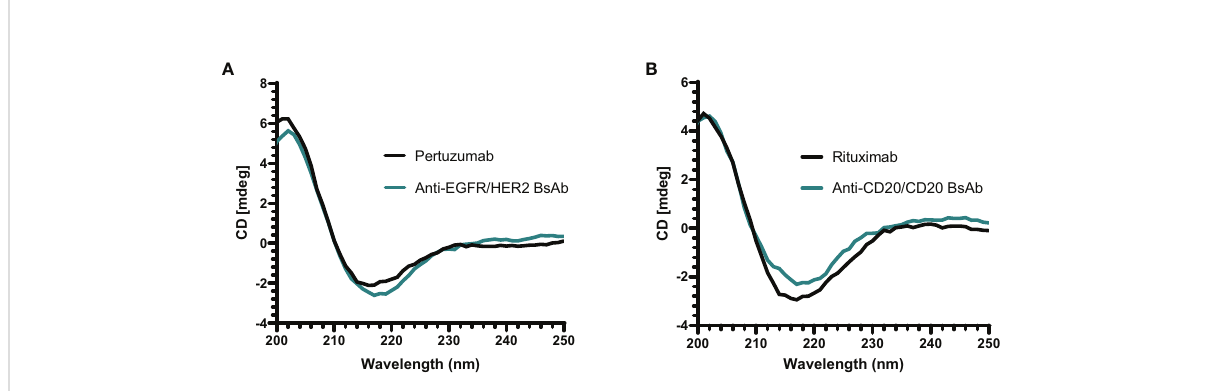
FIGURE 6 Far-UV CD spectrum of antibodies. (A) The spectrum of anti-EGFR/HER2 BsAb and its parental mAb (pertuzumab) show a negative band at around 218 nm. (B) The anti-CD20/CD20 BsAb and its parental mAb (rituximab) also show a similar spectrum of negative band as anti-EGFR/ HER2 BsAb at approximately 218 nm. All proteins were buffer exchanged in milli-Q water prior analysis and done in triplicate.